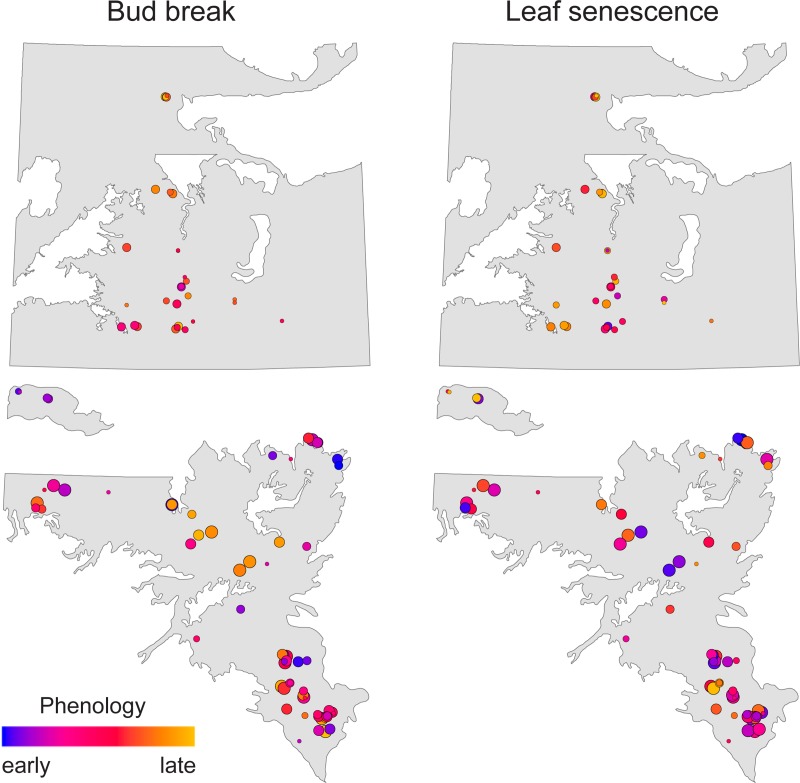
Breeding values (BV) of parents on southern breeding region test sites for phenology.The size of the circle indicates the reliability of the estimate (reliability: 0.1 = small circles, 0.7 = large circles). Map data was obtained from https://open.alberta.ca/opendata.